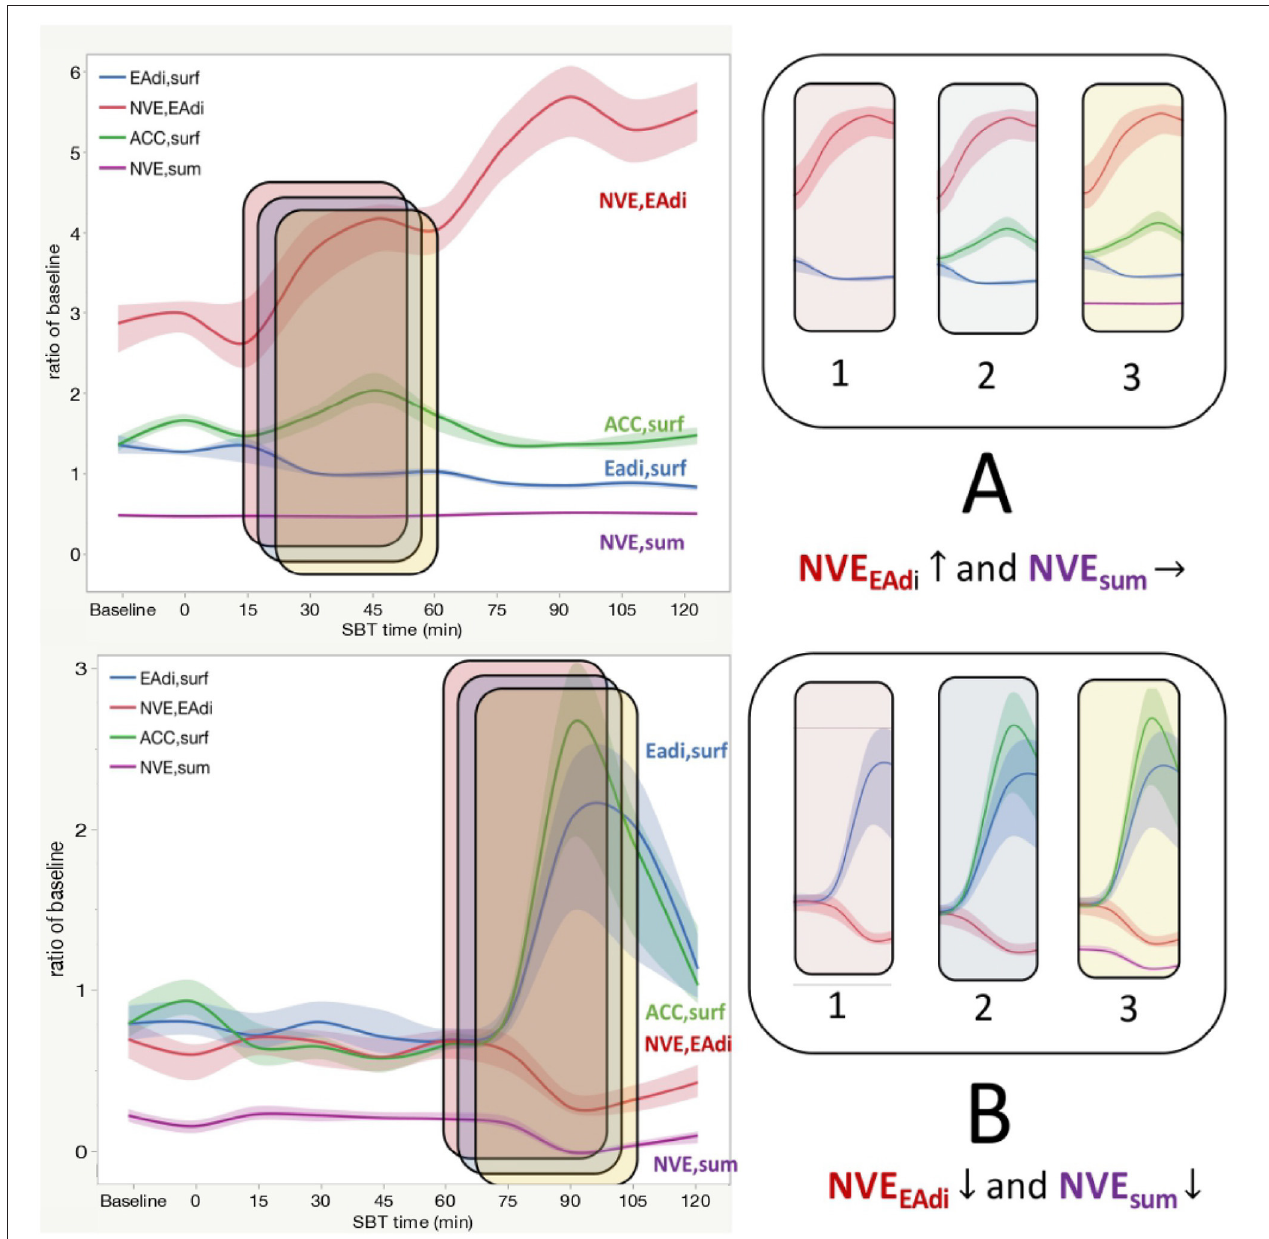
FIGURE 5 | For two representative patients ( A,B on the left) the diaphragm Electrical Activity (EAdi surf ), accessory muscles Electrical Activity (ACC surf ), Neuroventilatory Efficiency of the diaphragm (NVE EAdi ), and of the whole inspiratory muscles (NVE sum ) is shown during SBT. Lines indicated median values with bands indicating IQR. On the right side, a little time frame is sampled and Eadi surf , NVE Eadi , ACC surf, and NVE sum are added stepwise (from frames 1 to 3) to illustrate the different behavior of this variable, in particular of NVE EAdi and NVE sum . (A) . In this representative patient who fails SBT, a progressive increase in NVE EAdi (red line) together with a stable EAdi surf (blue line) is observed at the beginning of the trial (Panel 1). This can be interpreted with a prognostically good improvement of the diaphragm mechanical properties since it can produce more mL of tidal volume (TV) for each microV of EA. But if we look at panel 2, we see as accessory muscles EA increases (green line). The accessory muscles hiddenly ≪ help ≫ the diaphragm and this results in a larger TV. If we compute NVE taking into account all inspiratory muscles, it remains stable (panel 3). This is a case in which an apparent improvement in the neuromechanical properties of the diaphragm is falsely observed in presence of accessory muscles recruitment when it is calculated with the only diaphragm EA. (B) In this representative patient who success SBT, a steep increase in diaphragm EA (EAdi surf , blue line) is observed at the end of the CPAP trial (panel 1), together with a reduction in NVE EAdi (red line). This circumstance can be interpreted as a worsening in the diaphragmatic performance at the end of SBT, eventually because of the muscle fatigue and exhaustion, leading to a reduction in force (and tidal) generating capacity of the diaphragm. If we take into account accessory muscles, we can see as their EA increases parallel to the diaphragm (green line, panel 2). So, if NVE is calculated taking into account all inspiratory muscles (NVE sum , purple line) it decreases in the same way as that calculated only for the diaphragm (panel 3). In this case, EA and mechanical properties of the diaphragm and accessory muscles vary in the same manner, and diaphragm monitoring can be representative of the whole respiratory muscles. EAdi surf , diaphragm surface electrical activity; ACC surf , accessory muscles surface electrical activity; NVE EAdi , neuroventilatory efficiency for EAdi surf ; NVE sum , neuroventilatory efficiency for ACC surf .